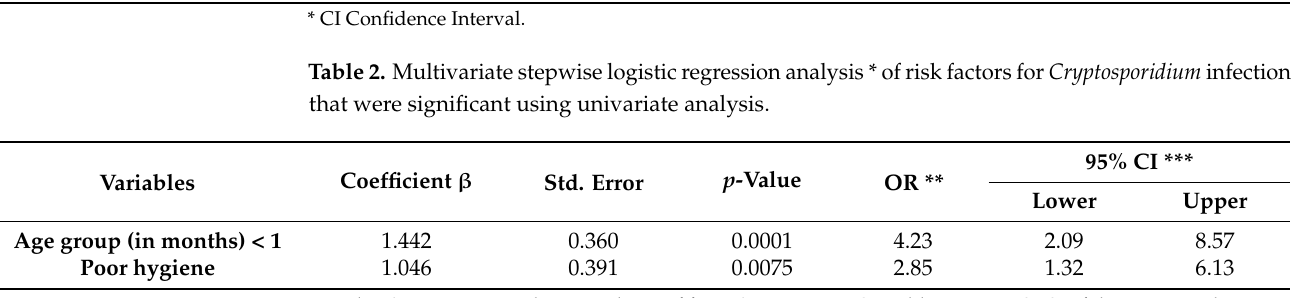
Table 2. Multivariate stepwise logistic regression analysis * of risk factors for Cryptosporidium infec- tion that were significant using univariate analysis.